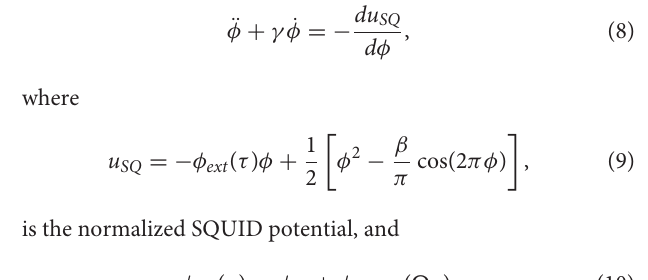
is the total current induced in the SQUID as provided by the resistively and capacitively shunted junction (RCSJ) model of the JJ [80] (the part of the circuit in Figure 1B contained in the brown-dashed square), 8 0 is the flux quantum, and t is the temporal variable. The three terms in the right-hand-side of Equation (2) correspond to the current through the capacitor C , the current through the resistor R , and the supercurrent through the ideal JJ, respectively. The combination of Equations (1) and (2)